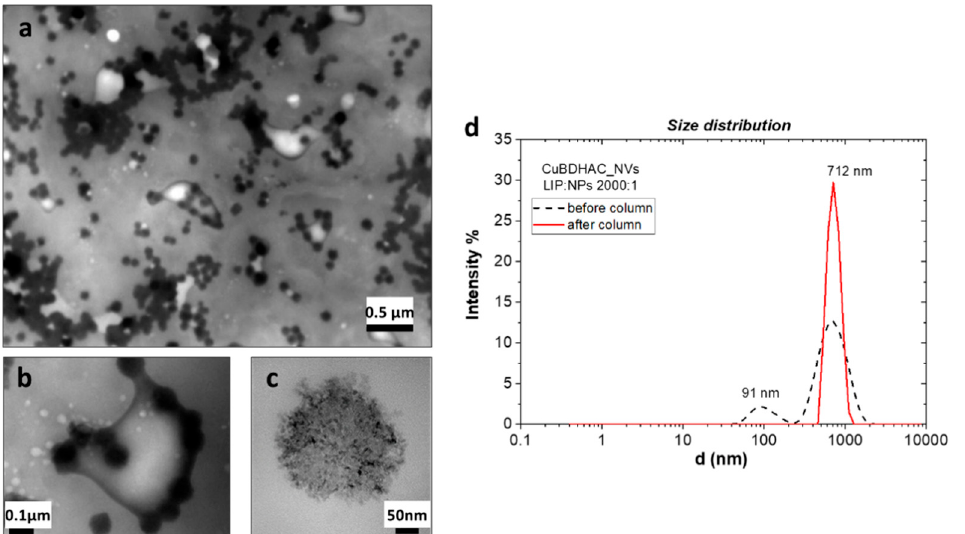
Figure 5. TEM image ( left ) and DLS ( right ) of the Cu@BDHAC–NV hybrids prepared at optimized conditions (LIP:NPs ratio 2000:1 w/w ). Overview of complex structures ( a ) and zoom on a hybrid vesicle ( b ) and on one NP cluster ( c ). Size distribution recorded before and after sample filtration ( d ).